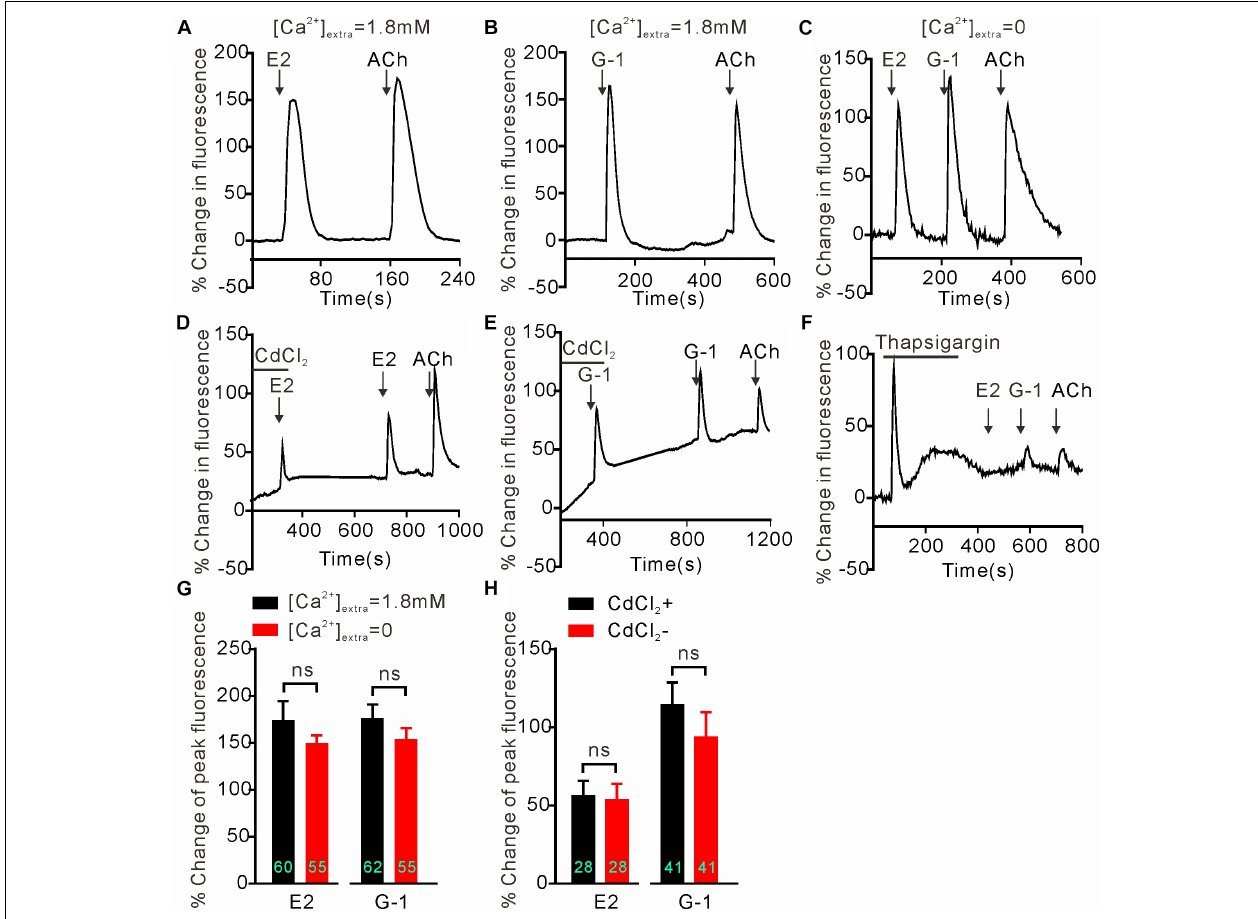
FIGURE 2 | Intracellular calcium rise elicited by E2 or G-1 was independent of calcium influx in SH-SY5Y cells. (A–C,G) E2 and G-1 both caused rapid Ca 2 + rise with or without extracellular Ca 2 + . (D,E,H) The non-selective voltage-gated calcium channel blocker CdCl 2 had no effect on the Ca 2 + rise induced by E2 or G-1. (F) Depletion of store Ca 2 + using thapsigargin prevented E2 or G-1 or ACh from evoking a rapid Ca 2 + rise. The example traces (A–F) are the average percentage change in fluorescence of 10–29 cells in one visual field. (G,H) Averaged peak percentage changes in fluorescence in different conditions. ns, not significant, unpaired (G) or paired (H) t -test, n = 28 ∼ 62 cells from three to four independent tests.